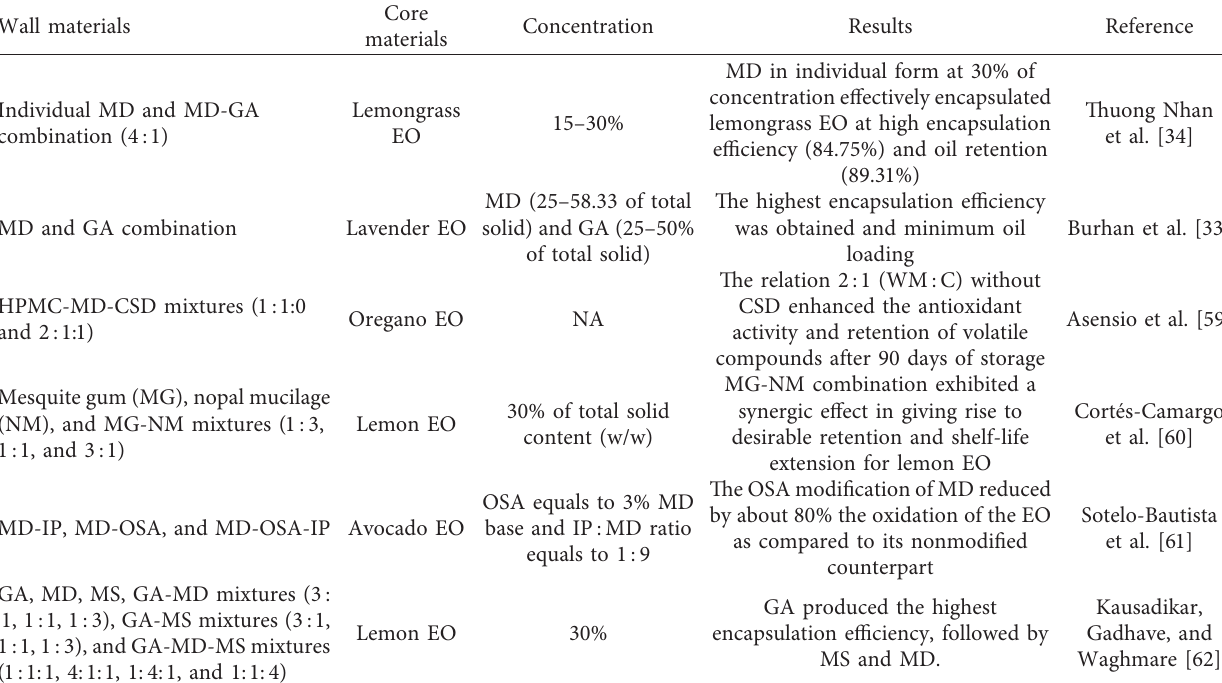
Figure 2: Factors affecting the encapsulation efficiency of spray-drying encapsulation. Table 1: Encapsulation of EOs in different materials by